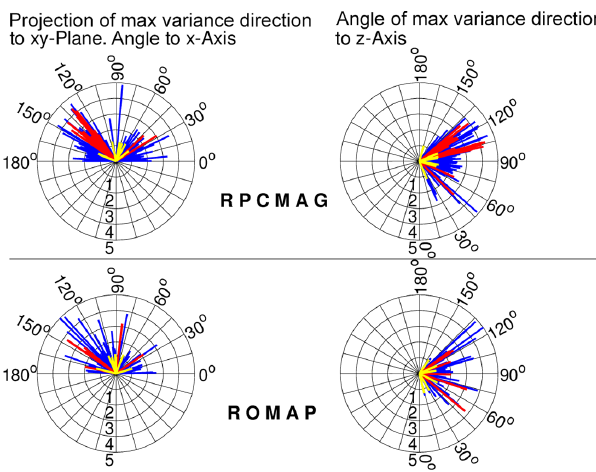
Figure 15. Distribution of maximum variance directions derived from RPCMAG (top) and ROMAP (bottom) data for the complete descent. Colour coding – blue: all MVA results, red: elliptical/more complex polarization ( λ max /λ med ≥ 2 and λ med /λ min ≥ 3), yel- low: circular polarization ( λ max /λ med ≤ 1 . 3 and λ med /λ min ≥ 3). The radial component represents the eigenvalue